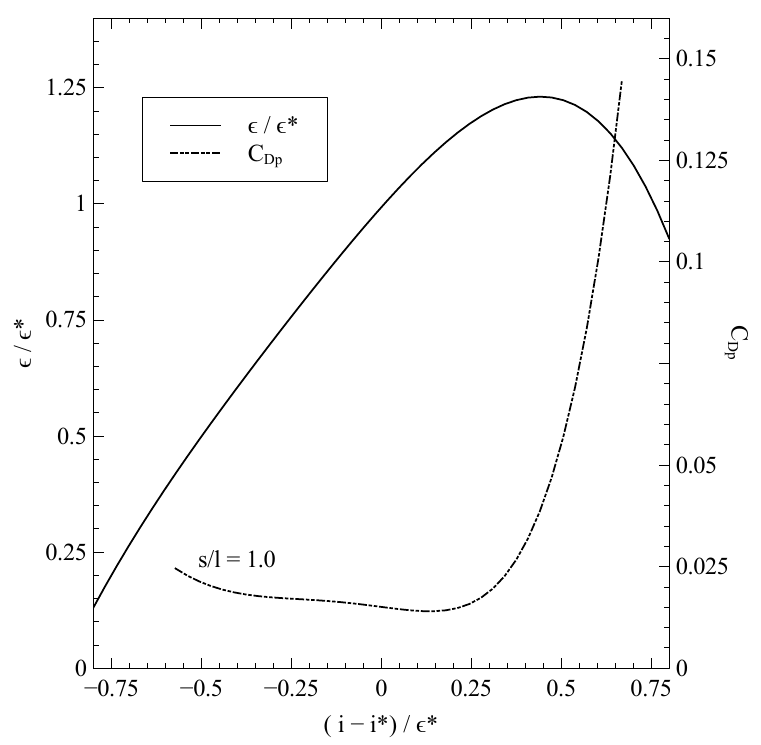
Figure 7. Deflections and drag coefficients at other than nominal incidences (see [25,26]).